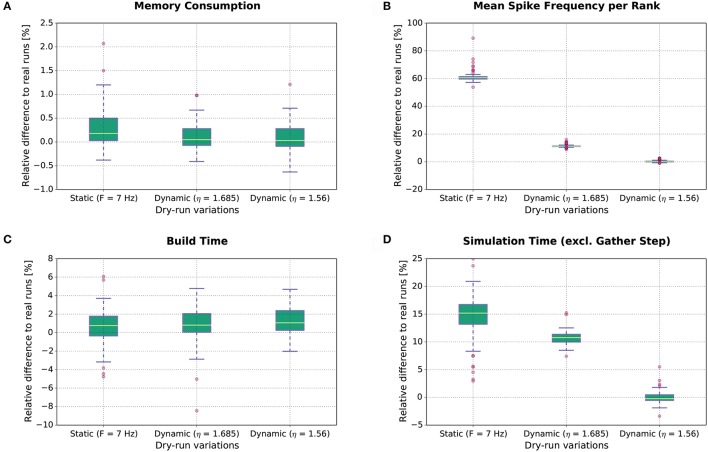
Dry-run performance relative to corresponding real simulations. The relative difference between real and dry runs is computed by (ddry − dreal)/dreal with d being the measured value.